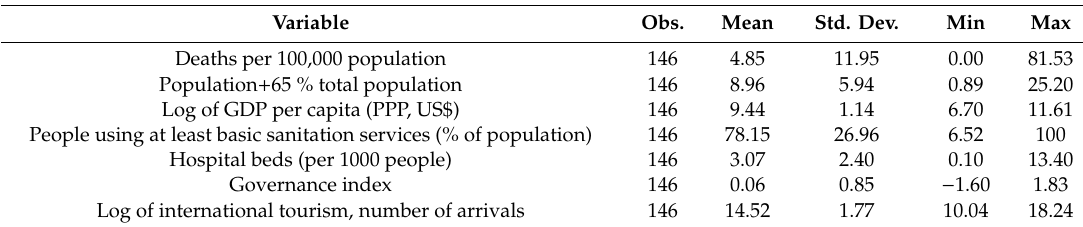
Table 1. Summary